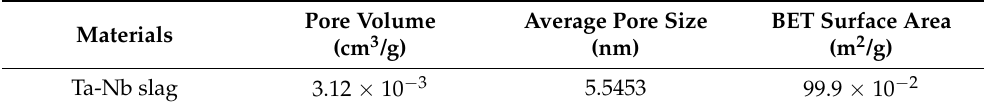
Table 5. Tantalum-niobium slag performance